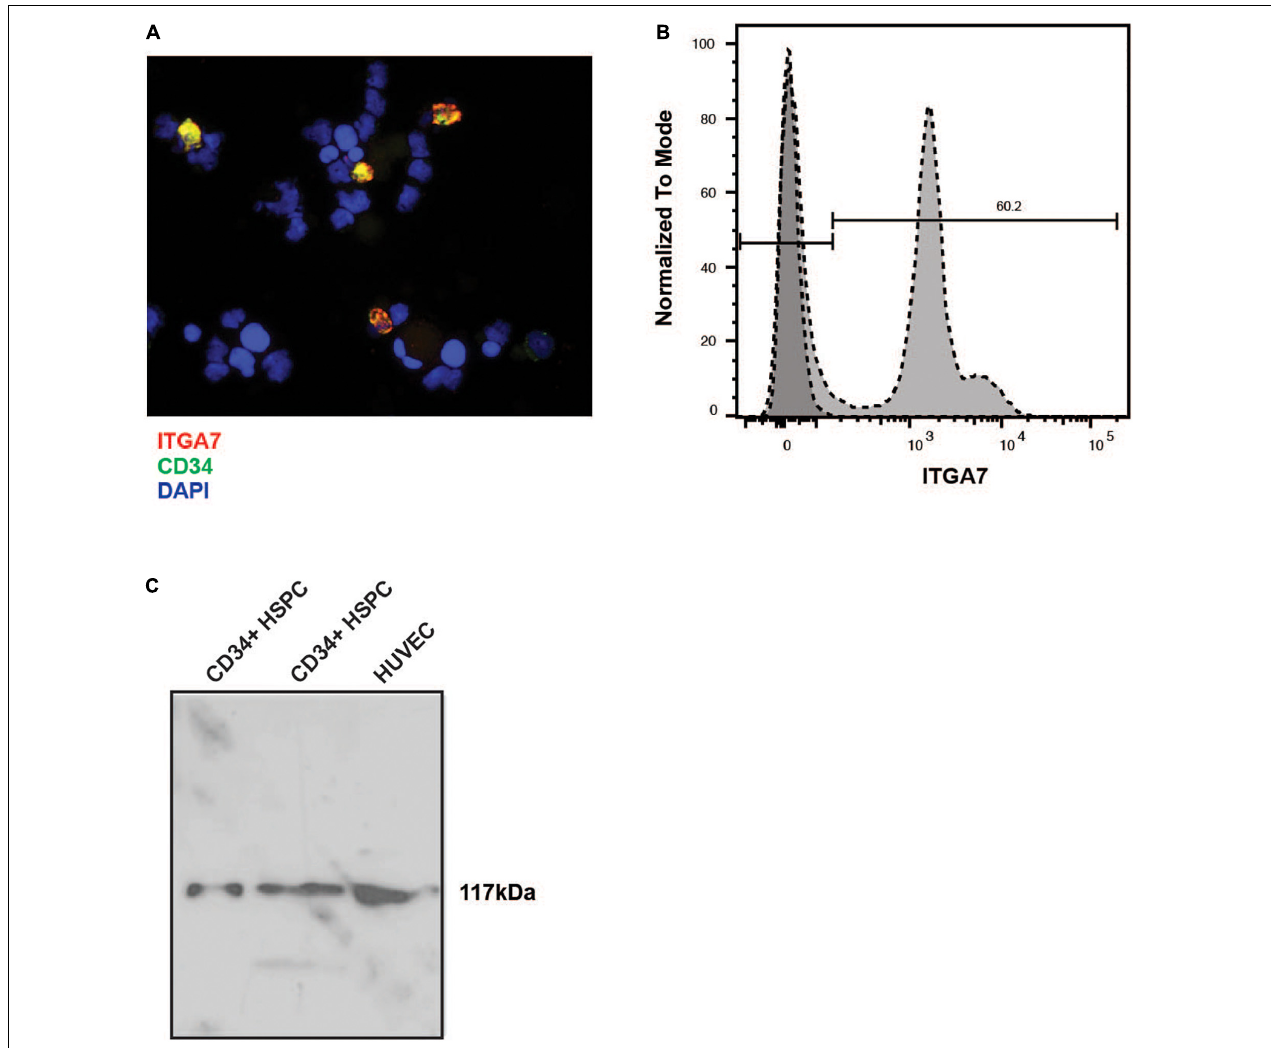
FIGURE 4 | Immunostaining of lineage negative HSPC with the anti- α 7 integrin antibody. (A) The lineage-negative CBMNC fraction fixed by cytospin centrifugation was labeled with a mouse monoclonal anti-human integrin α 7 chain antibody (red) and a rabbit monoclonal anti-human CD34 antibody (green). The cells were counterstained with DAPI (blue). The merged picture shows that all CD34 + HSPC express integrin α 7. Representative of three independent experiments. (B) Lin- CD34+ cells were labeled with the unconjugated integrin antibody followed by an incubation with FITC-conjugated secondary antibody, and measured by flow cytometry. Representative plot of three independent experiments. (C) Two different preparations of lin- CD34+ cell extracts were analyzed by immunoblotting. An extract from HUVEC cells was used as a positive control. In all extracts a band of 117 kb can be